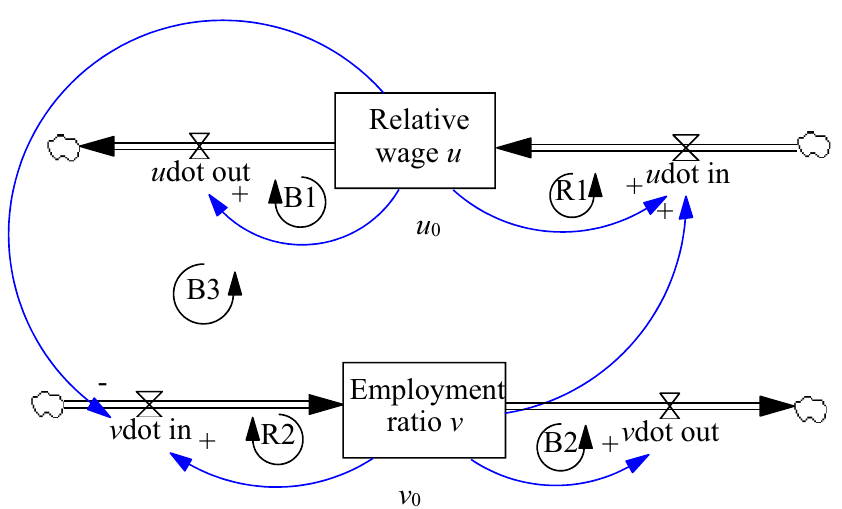
Fig. 1 A condensed stock-and-flow structure of M-1 and B-1: total number of feedback loops is 5, among them: first order—2 positive and 2 negative, second order—1